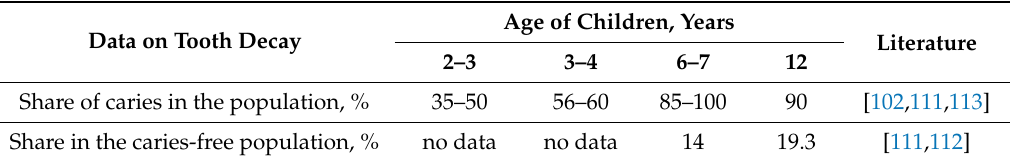
Table 3. Selected data on the occurrence of caries in the population of developmental